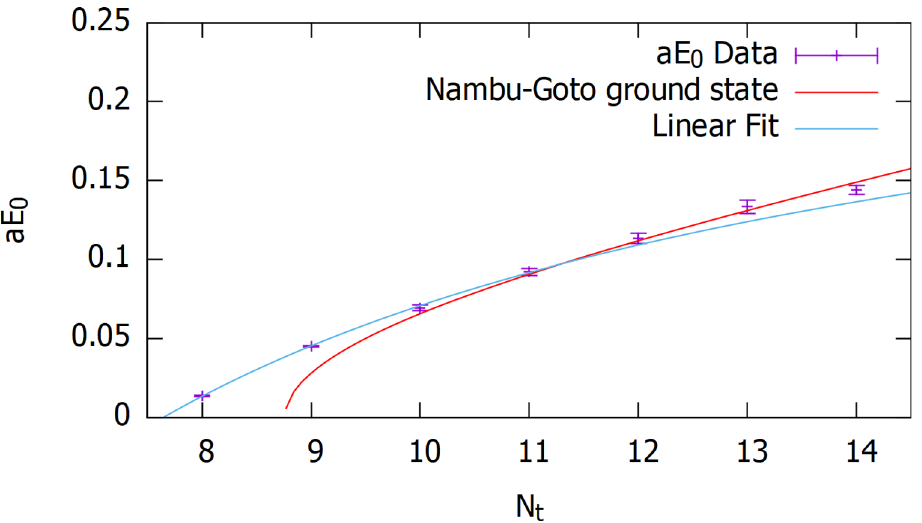
Figure 4 . Fits of our data for the ground-state energy E 0 at β = 9 according to the prediction from the Nambu-Got¯o model, eq. (6.2) (red line) and according to the Ansatz of a linear dependence of E 0 on the temperature, according to eq. (6.5) (blue curve). Note that the quantity on the horizontal axis of this plot is the inverse of the temperature, in units of the lattice spacing.